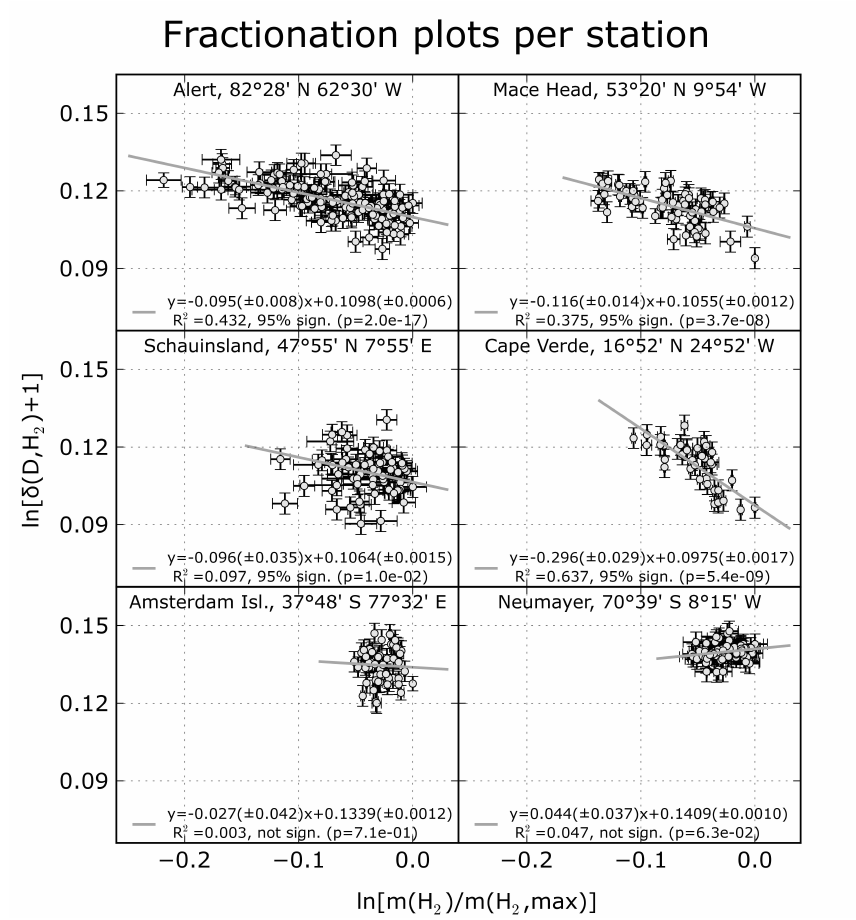
Fig. 5. Fractionation plots of the datasets from the different stations. Plotted are ln( δ D+1) vs. ln( m (H 2 ) / m (H 2 , max)) with m (H 2 , max) the maximum mixing ratio found. Grey lines are the fitted lines obtained from the Weighted Total Least-Squares fitting routine. Error bars indicate one standard deviation. Indicated errors in the fit parameters indicate one standard error. R 2 is the squared correlation coefficient and p is the p -value for the F statistic, both calculated as for an “ordinary” least squares fitted